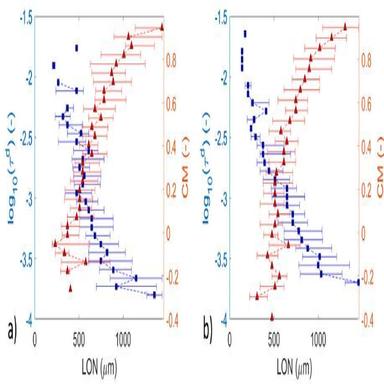
Length of neighbourhood as a function of differential tortuosity and collective motion for a) Tape A, and b) Tape B. The blue squares correspond to the median logarithm of differential tortuosity (left axis), while the red triangles correspond to the median collective motion (right axis). The error bars represent the interquartile range. (For interpretation of the references to colour in this figure legend, the reader is referred to the Web version of this article.)